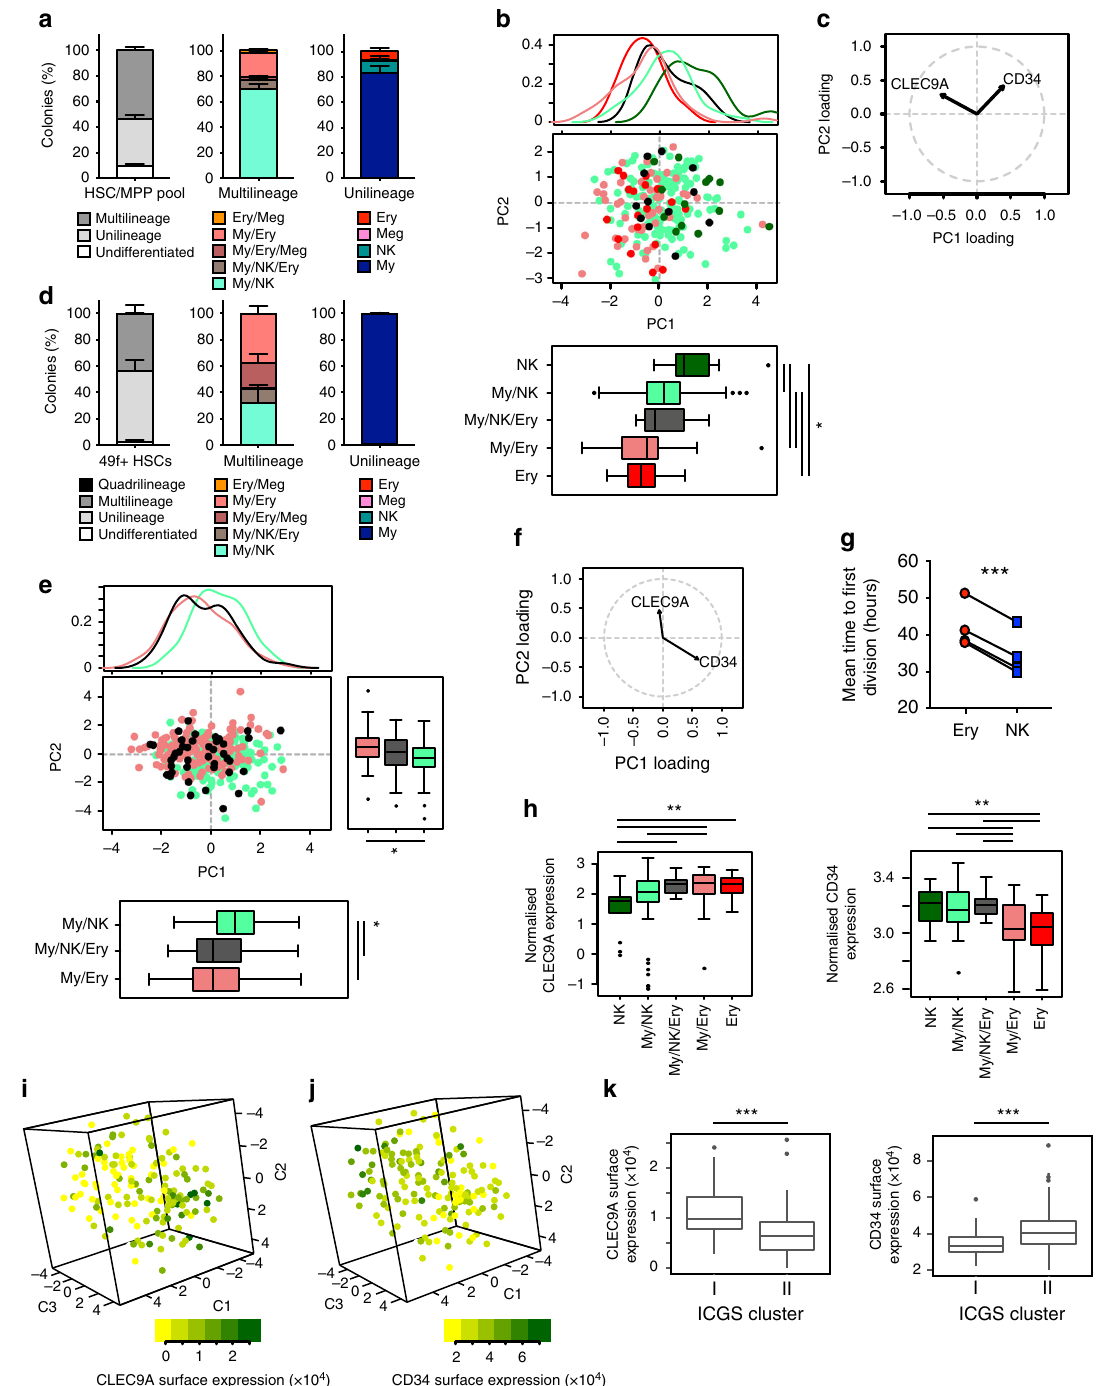
Despite the delay in the fi rst division of cells differentiating towards the Ery lineage, My/Ery colonies were averagely signi fi cantly larger than any other type of colony, including multilineage colonies (Supplementary Fig. 1i) suggesting that, at least in this assay, expansion is maximal along the Ery differentiation branch. In summary, we uncovered pre- determined functional polarisation within the HSC/MPP pool and the highly puri fi ed 49f + HSC compartment, which separates single cells with My/Ly potential from those with My/Ery or multilineage